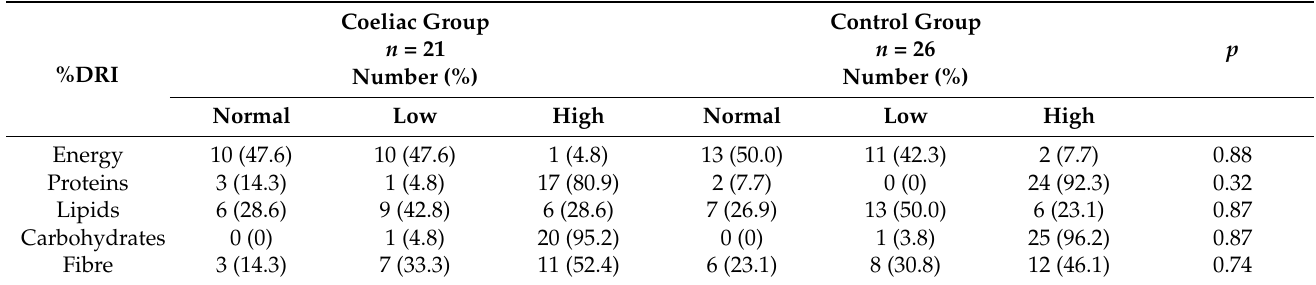
Table 7. Numbers of children with normal, low and high dietary reference intake (%DRI) for total energy and macronutrients in CD and control subjects.